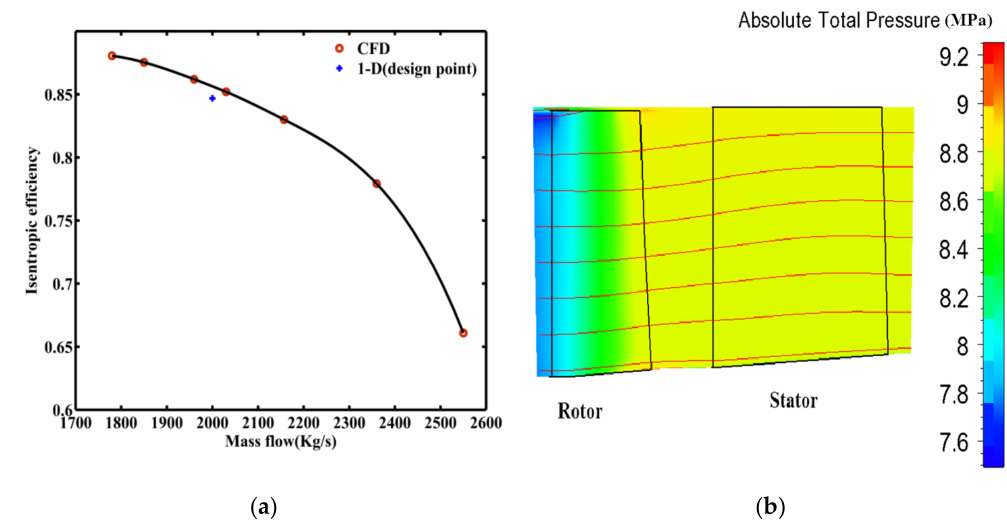
Figure 8. The performance of the first stage. ( a ) Efficiency of the first stage; ( b ) Total pressure distribution in the meridional